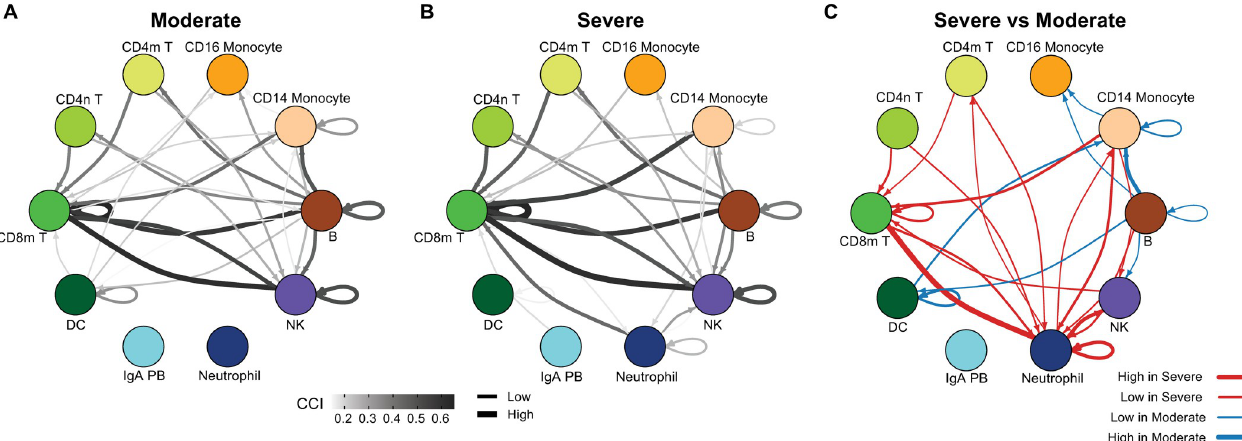
Fig 2. Comparison of cell-cell interactions in COVID-19 patients in PBMC of varying severities. A—B. Network representing the group specific cell-cell interaction (CCI group ) considering different disease severity as groups in the six PBMC datasets from (A) moderate patients and (B) severe patients. The nodes represent major cell types and the edges represent aggregated tCCI interaction signals across individuals from the same group. Thicker and darker edges indicate stronger cell-cell interaction signals. Only the edges with top 10% tCCI signals are illustrated in the network. C. Network representing the difference of cell-cell interaction between severe and moderate patients. The nodes represent cell types and an edge measures the difference in cell-cell interaction. A red edge indicates an interaction higher in severe patients and a blue edge indicates an interaction higher in moderate